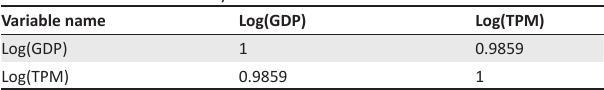
TABLE 1-A1: Correlation